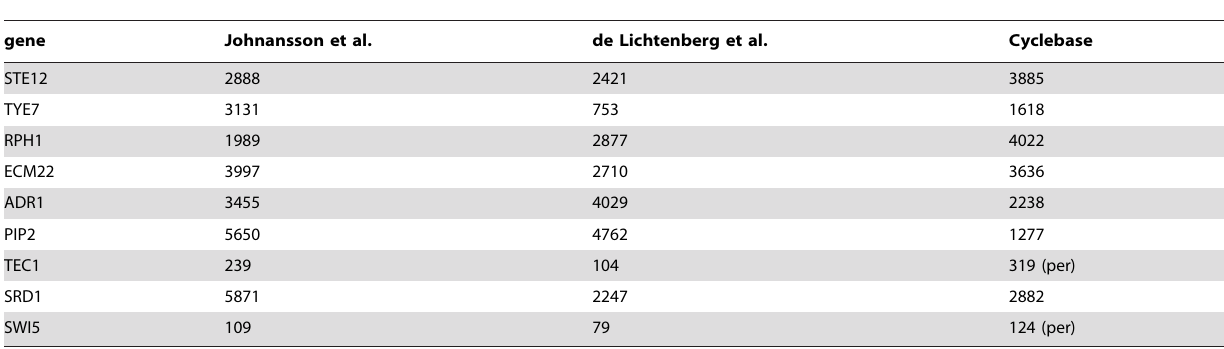
Table 2. Nine candidate genes (first column) to be periodic.